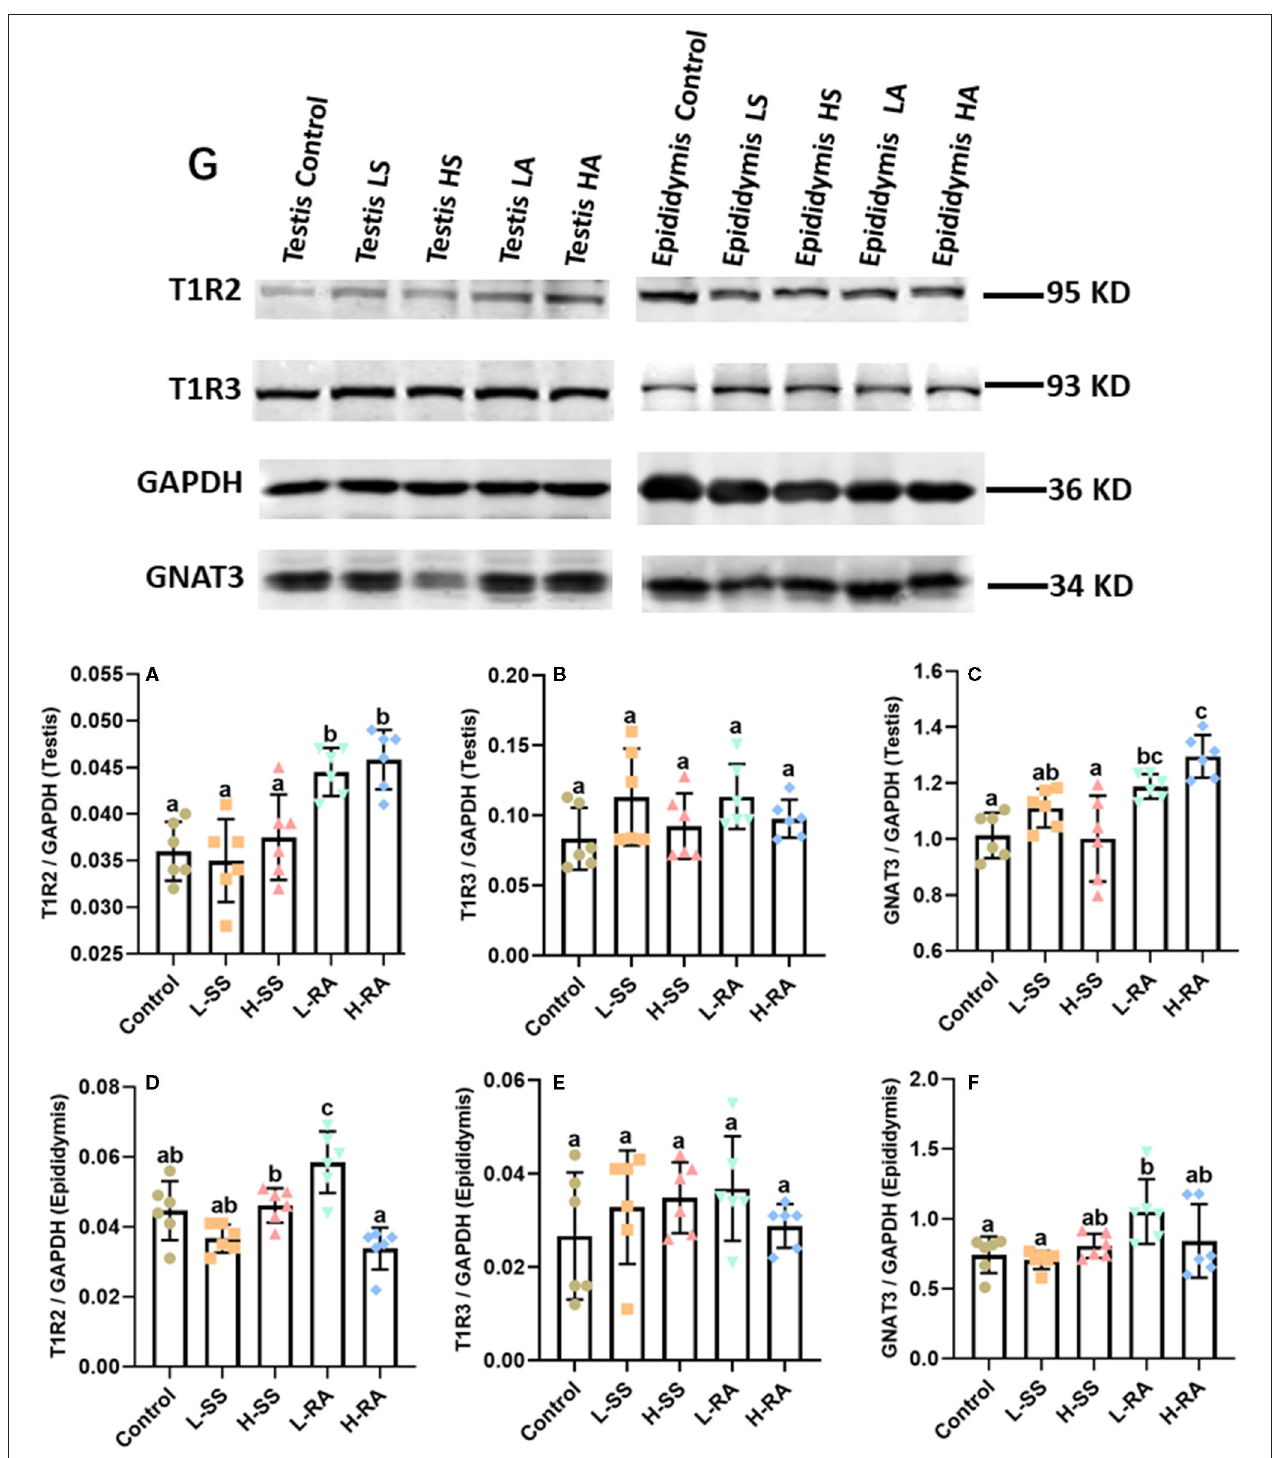
FIGURE 8 | Effect of dietary non-nutritive sweetness drinking on the expression of sweet-tasting proteins T1R2, T1R3, and GNAT3 in testis and epididymis in male guinea pigs. Animals in the control, L-SS, H-SS, L-RA, and H-RA groups were supplied water solution with normal water, 1.5mM sodium saccharin, 7.5mM sodium saccharin, 0.5mM rebaudioside A, and 2.5mM rebaudioside A for 28 days, respectively. Equal amounts of protein lysate 50 µ g were separated and incubated with primary antibodies of T1R2, T1R3, GNAT3, and GAPDH (8G) ; GAPDH was used as an internal control. The intensities of blots were calculated with target protein bands to corresponding GAPDH (8A–F) . Data are shown as means ± SD ( n = 6). Bars with different letters denote significant differences ( P < 0.05).